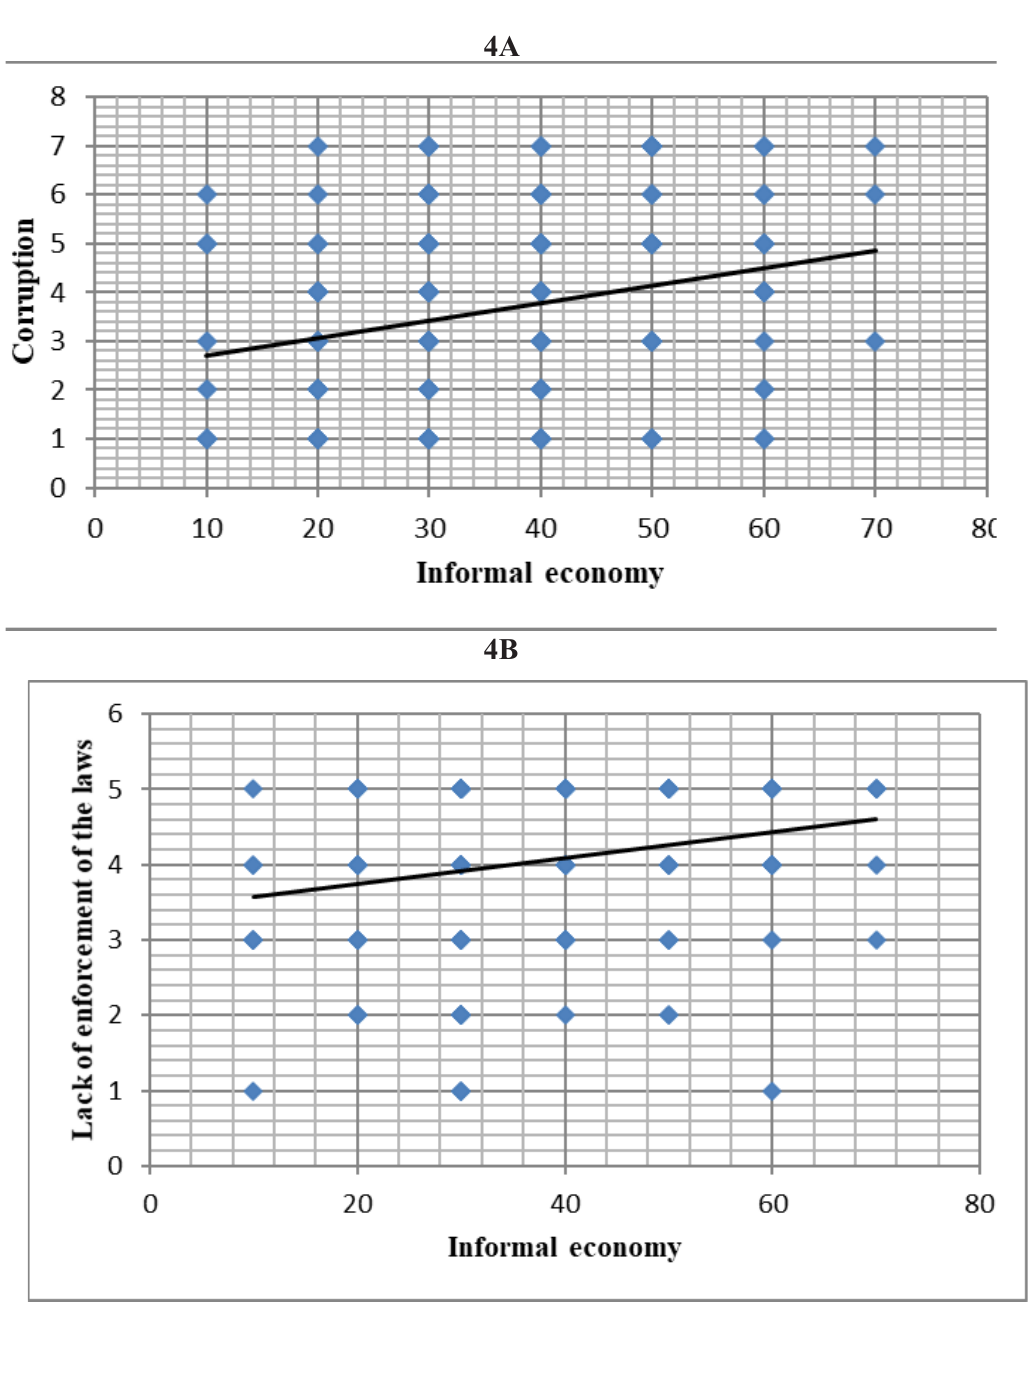
Figure 4: Institutional Quality and the Informal